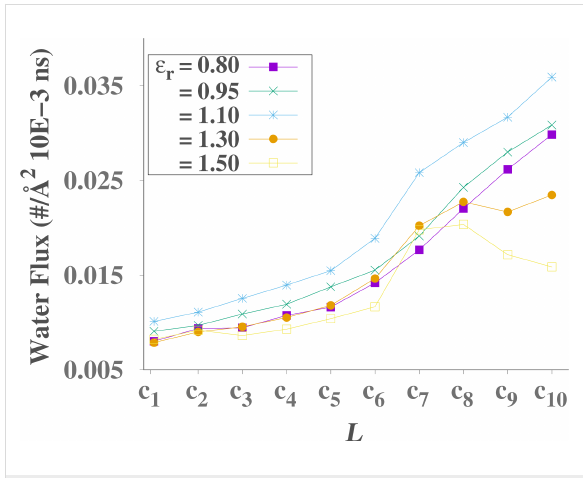
Figure 10: Graph of water flux in different regions of the nanocone (Figure 3), for different values of the potential well ε r .